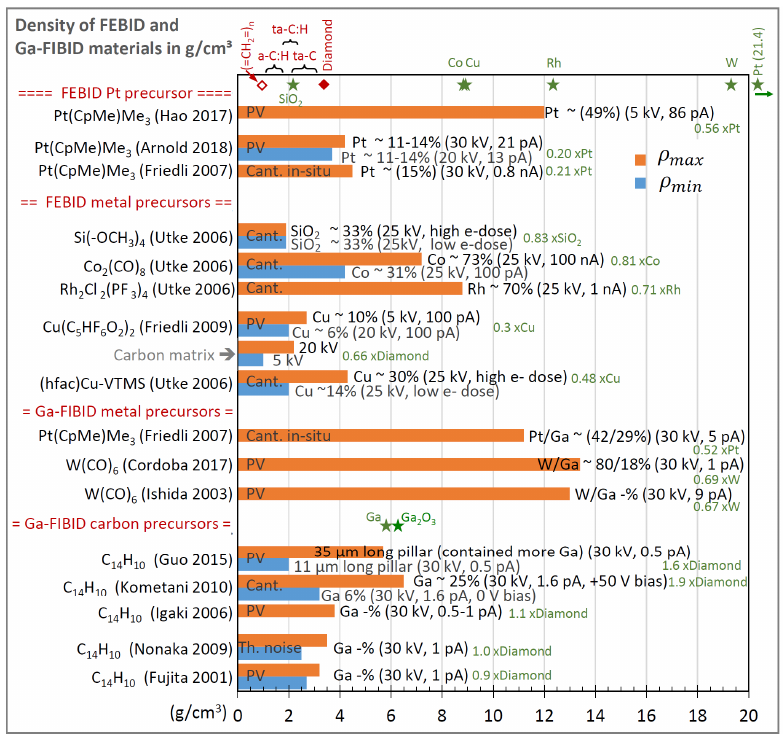
Figure 22. Summary of density measurements of FEBID and FIBID (noted as FEB and FIB) grown materials. The vertical axis lists the precursor molecule used to grow the structure and the author reference; if not noted otherwise, the density is reported for as-grown material. Maximum and minimum densities as far as accessible, the metal contents, and the measurement methods are indicated. Metal contents given in parentheses were interpolated in the respective reference but not explicitly measured. The measurement methods are pillar vibration (PV), cantilever-based (Cant.), and thermal noise (Th. Noise). Bulk density values of pure compounds and elements are also indicated. The density ratios of deposit to bulk are noted in green for the maximum deposit